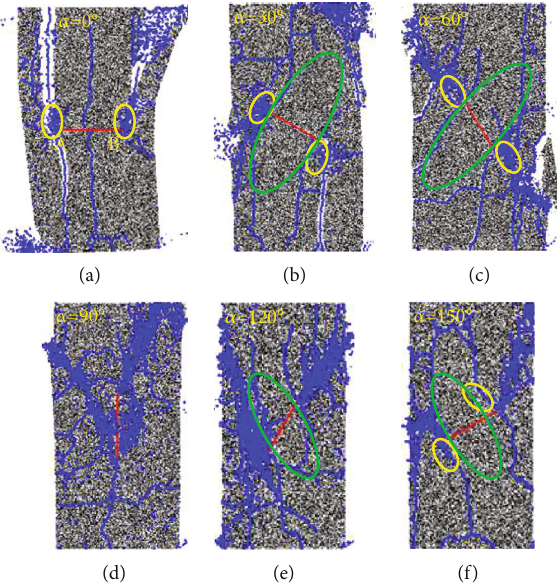
Figure 12: Failure mode of the specimens containing a single precrack.